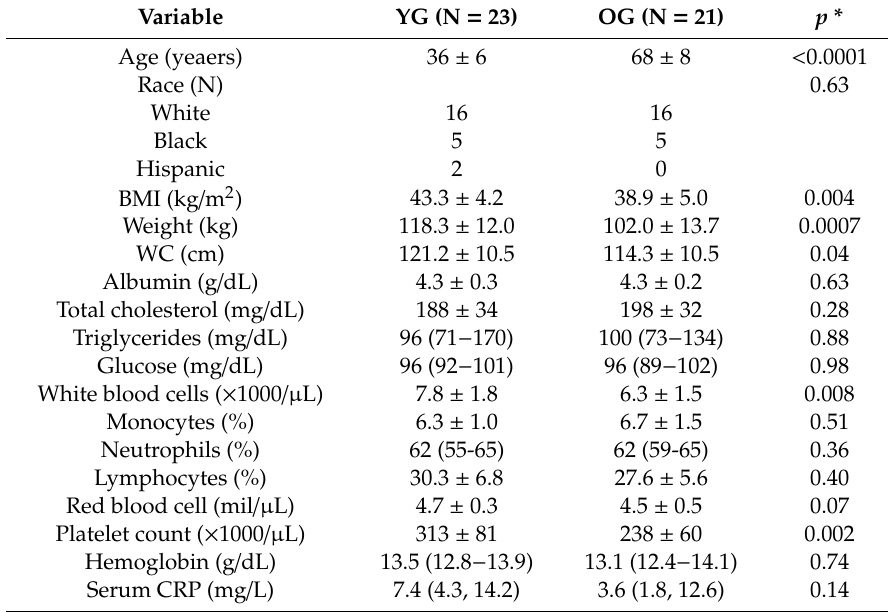
Table 1. Subject